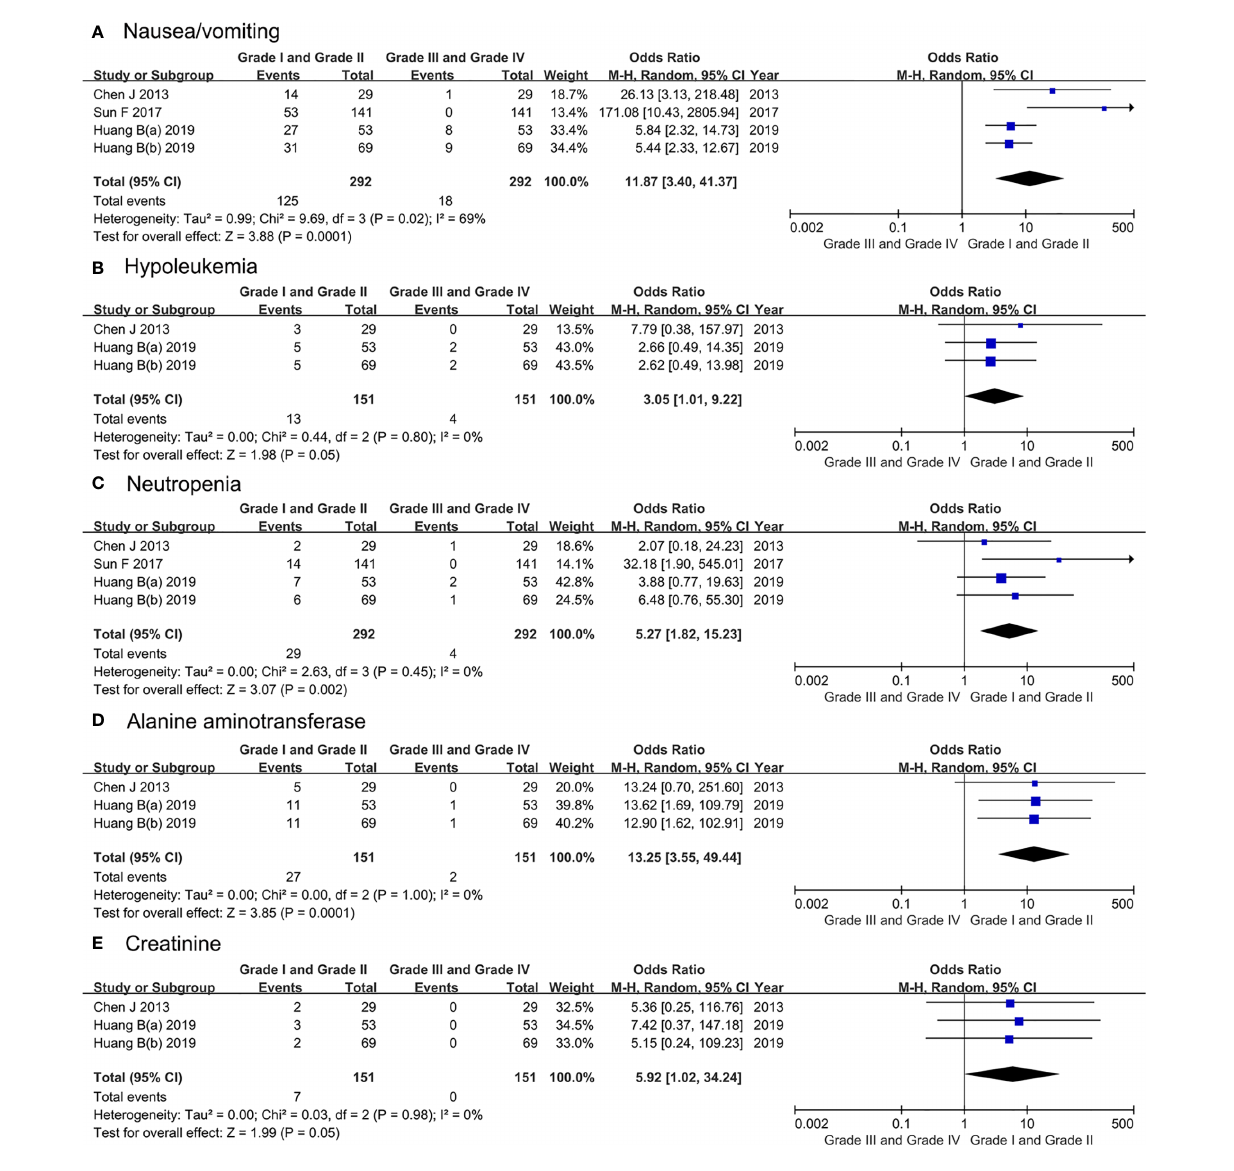
FIGURE 6 | Forest plots showing the result in IAC related adverse events including (A) nausea/vomiting, (B) hypoleukemia, (C) neutropenia, (D) alanine aminotransferase, and (E) creatinine. M – H, Mantel – Haenszel; CI, con fi dence interval; df, degrees of